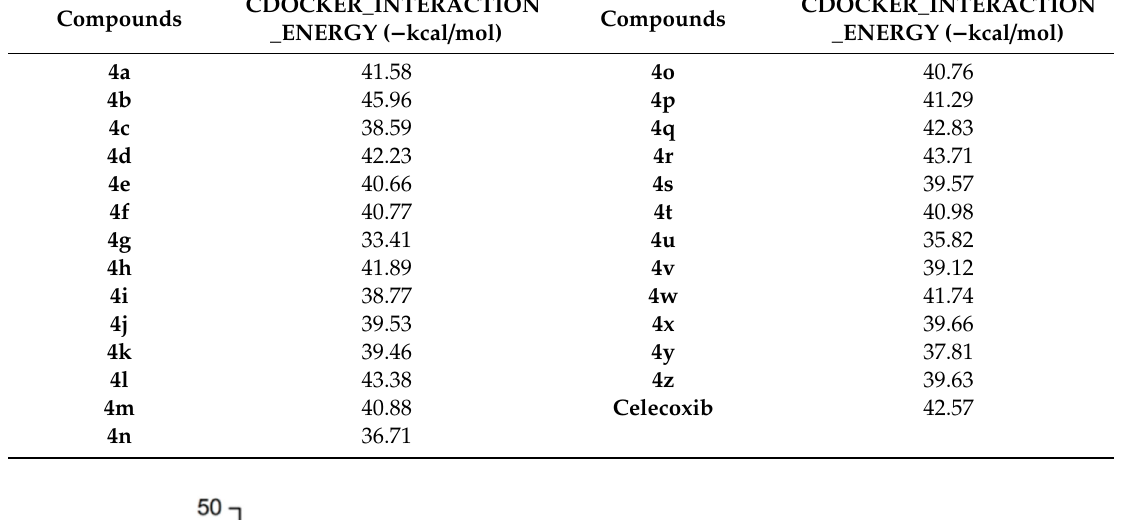
Table 5. The CDOCKER_INTERACTION_ENERGY from the docking of compounds 4a – 4z .